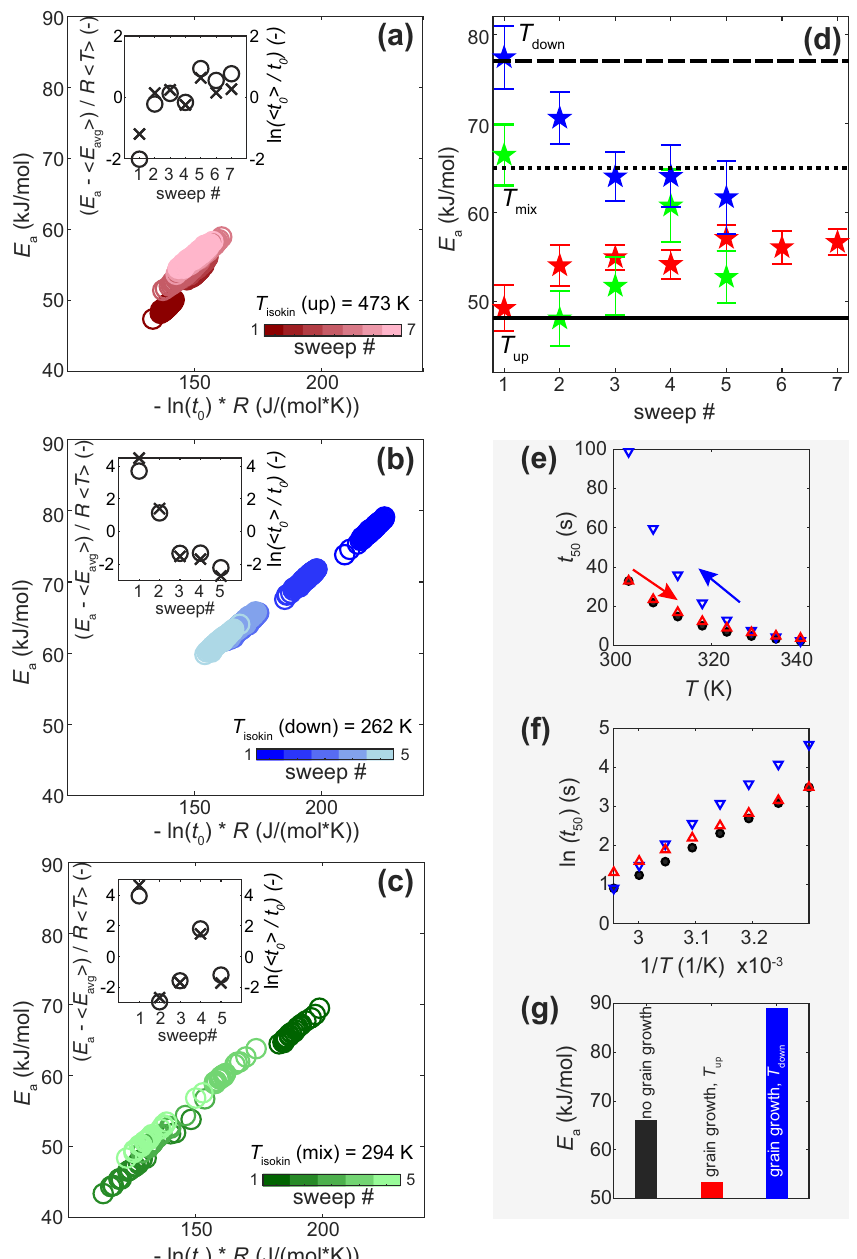
Fig. 5 Compensation effect in single particle Arrhenius parameters. a Modi fi ed Cremer – Constable plots at desorption for three samples measured with different T -sweeps: up — red; ( b ) down — blue and c mixed — green. Each subsequent T -sweep in a set is colored as a lighter shade of main color (colorbar). As a measure of compensation, insets show the normalized change in activation energy, ( E a – < E avg >) / RT (where E a is the average value for 180 ( T up and T T E down ) or 24 particles ( mix ) in each sweep, < avg > is the average of the entire set, black circles), and logarithm of the pre-exponential factor (ln(< where t 0 is the average value for the particles in each sweep and < t 0 > is average of the entire set, black crosses) as function of measured T -sweeps. T isokin for all data measured with each of the T -sweep directions ( T mix , T down and T up ) lumped together was calculated according to ref. 30 . d Average E a of the particles for each of the measured sweep directions (colored stars: T up — red, T down — blue and T mix — green). Black lines denote E a values at desorption for annealed Pd nanoparticles 39 of 2 – 5 nm in size (dotted), annealed Pd disks 38 of 190 nm in diameter and 25 nm in height (dashed) and Pd foil 37 of 2.5 – 5 µ m in thickness (solid). Error bars indicate 95% con fi dence bounds of the Arrhenius fi t. See analogous fi gure for absorption in Supplementary Fig. 13. In e – g we simulate three scenarios for the derivation of the apparent activation energy at desorption: the ideal case without grain growth (black circles), grain growth with T -sweep up (red triangles) and grain growth with T -sweep down (blue triangles): ( d ) t 50 vs. T , ( e ) Arrhenius plots of ln( t 50 ) vs. 1/ T and f corresponding apparent activa t ion energy for each